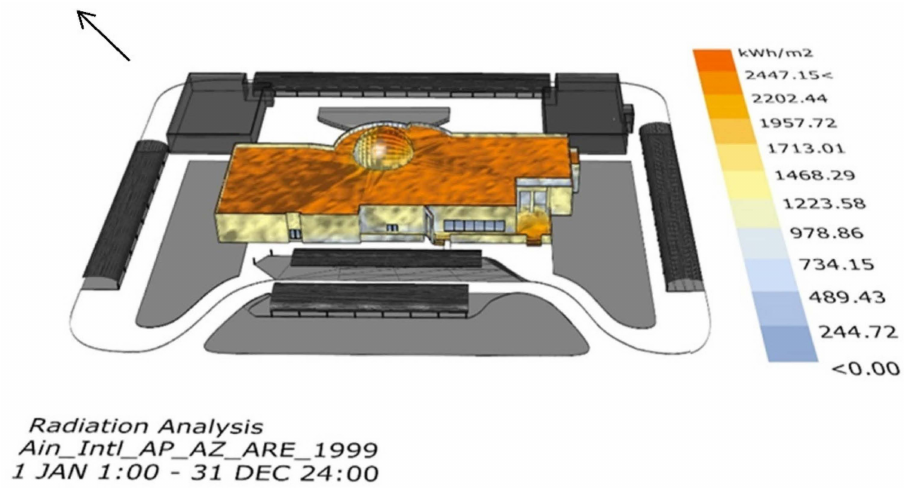
Figure 8. Radiation analysis of the base